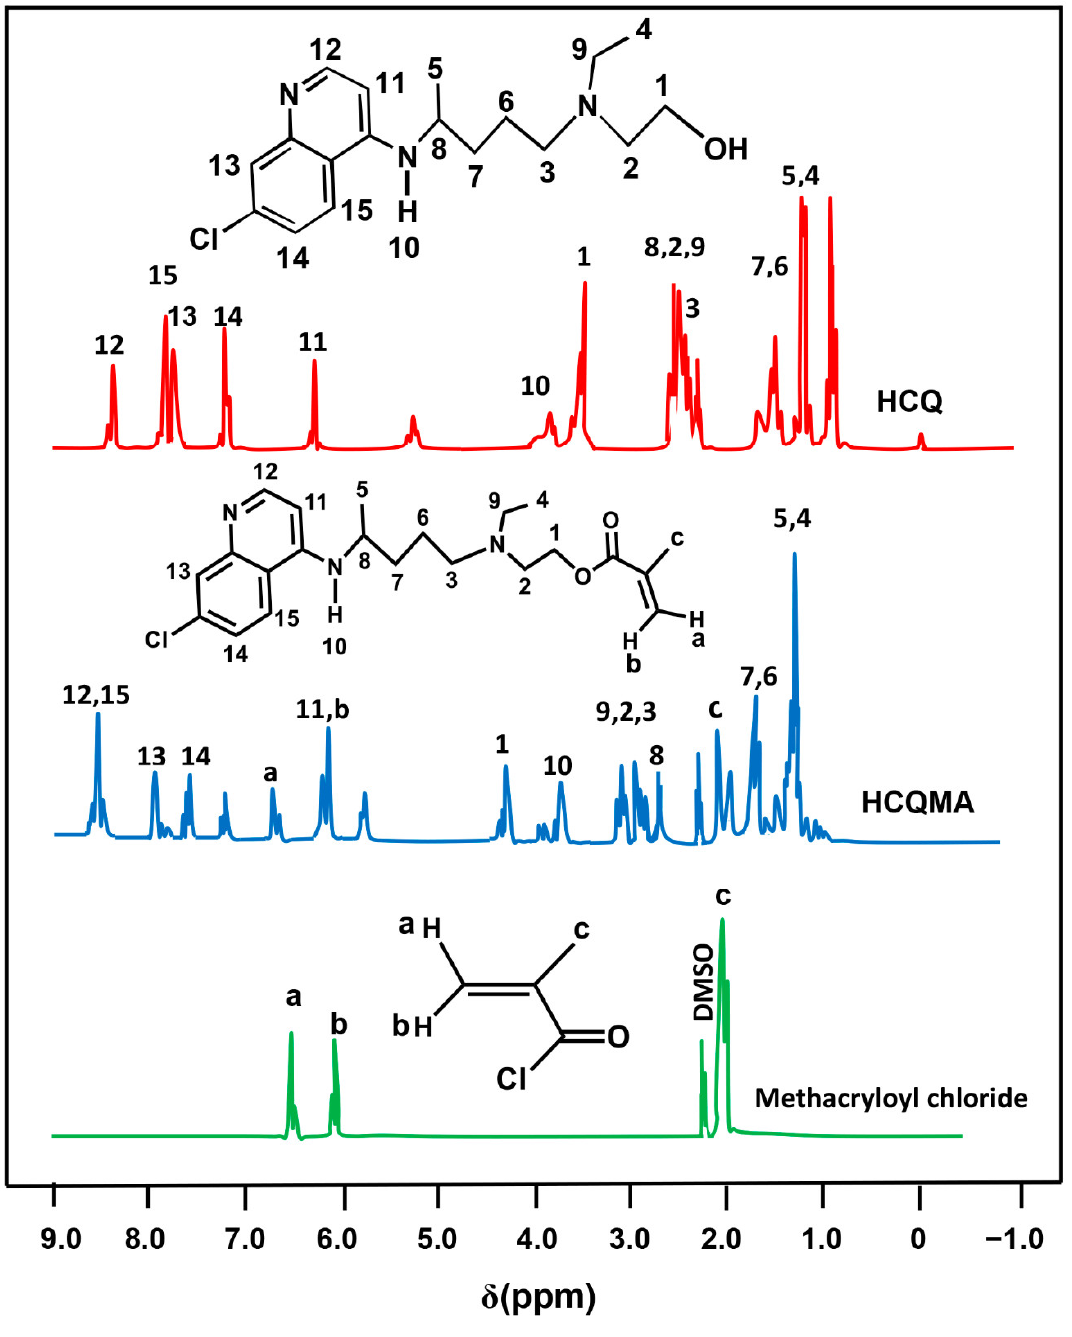
Figure 3. 1 H NMR spectra of pure HCQ, methacryloyl chloride and CQMA. The 1 HNMR spectra of CQMA- co -HEMA15, selected among the other copolymers by their higher density in chloroquinyl groups, the PHEMA and PHCQMA homopolymers were grouped in Figure 4. As in the case of the FTIR analysis, the spectra of the copolymers revealed the presence of the combination of all the signals attributed to the two monomeric units, CQMA and HEMA, with the exception of those attributed to the protons (a) and (b) of the vinyl double bonds (sites of the polyaddition reaction), which appeared on the monomers spectra of Figure 3.